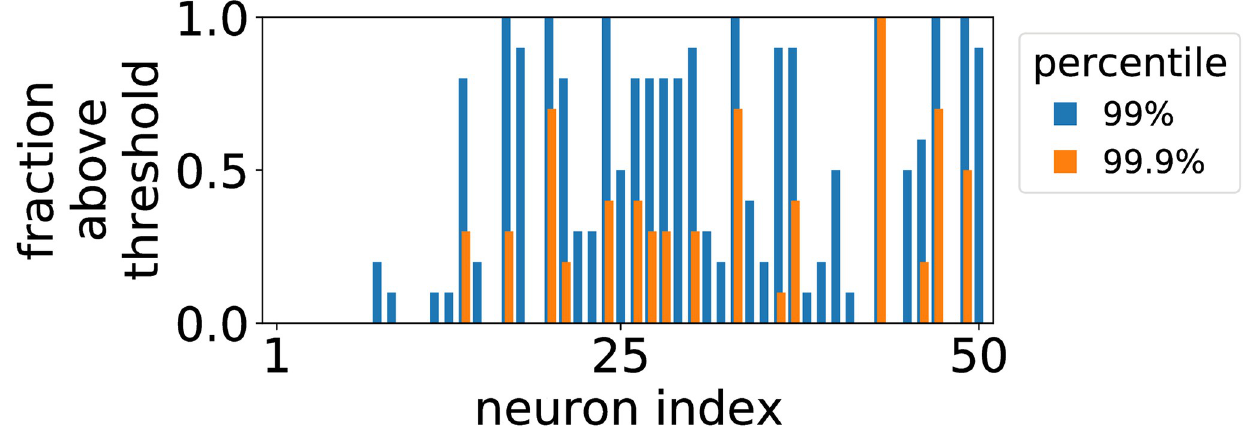
Fig 6. Fraction of times out of 10 Monte Carlo samples that neuron column uniformity exceeds 99% and 99.9% percentile cutoffs out of column uniformities over all neurons and eigenmatrices. See also Fig S in S1 Text.